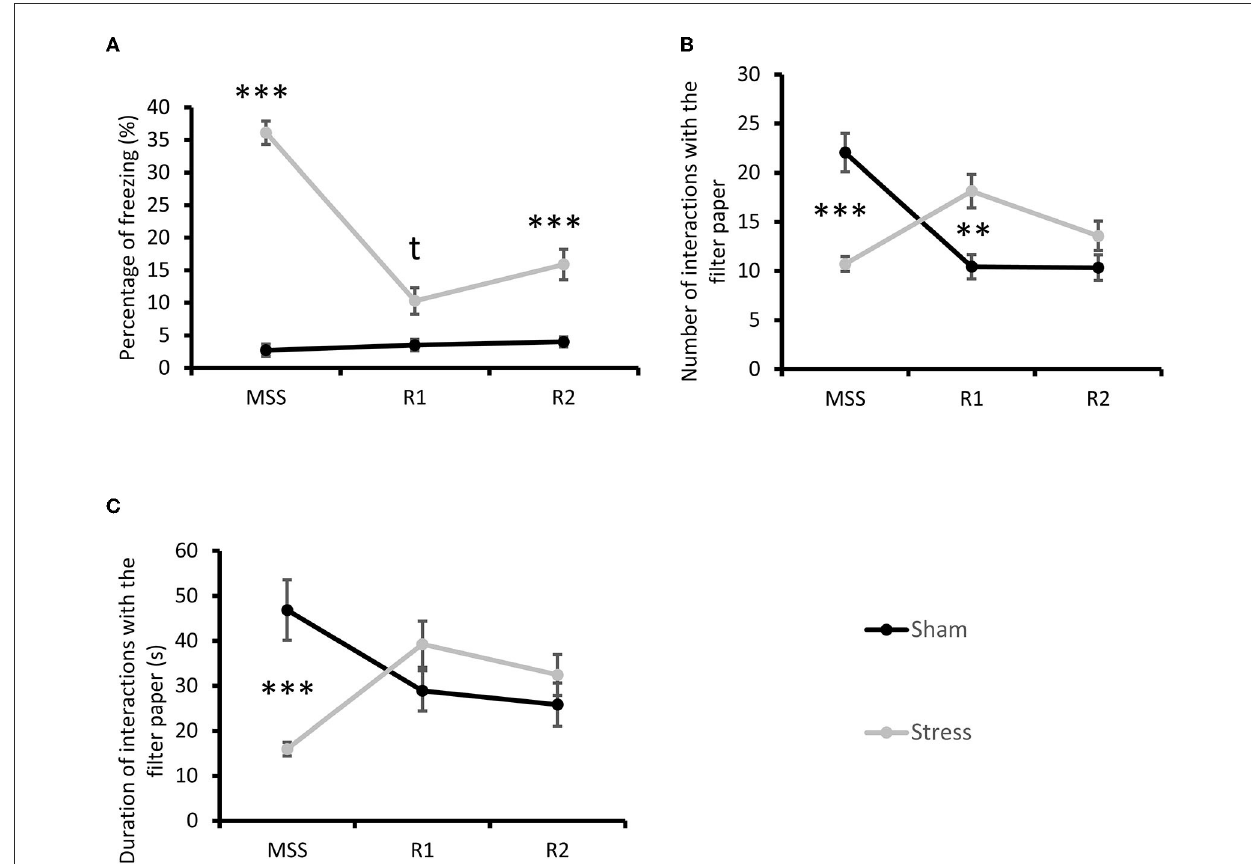
FIGURE2 Multisensorial stress context exposure. (A) Percentage of freezing during the 10-min MSS, sham-MSS, and re-exposures. Post-hoc Bonferroni test t p < 0.10, *** p < 0.001. (B) Number of interactions with TO during the 10-min MSS, sham-MSS, and re-exposures. Post-hoc Bonferroni test ** p < 0.01, *** p < 0.001. (C) Duration (in sec) of interaction with TO during the 10-min MSS, sham-MSS, and re-exposures. Post-hoc Bonferroni test *** p < 0.001. Results are expressed as mean ±